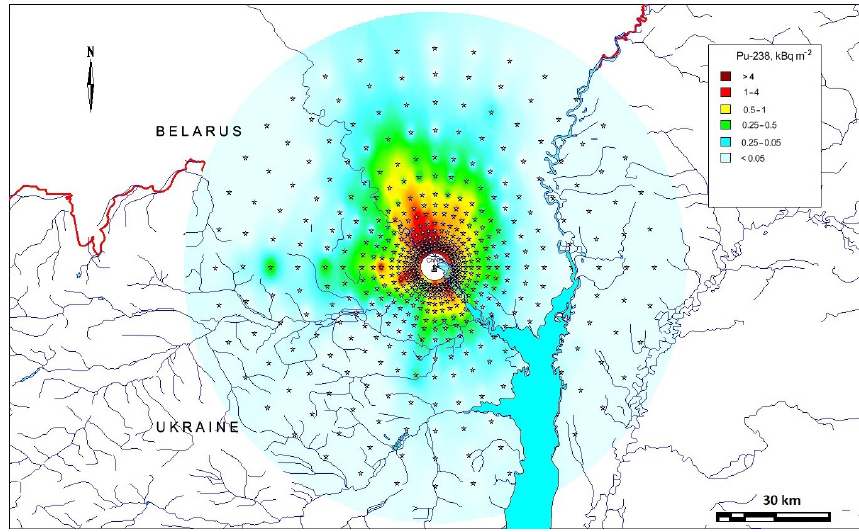
Figure 8. The fallout density of 238 Pu (kBqm 2 ) corrected to 6 May 1986; estimated from measurements of 144 Ce in the soil and estimated activity concentrations in the fuel of the ChNNP reactor number four (note that no data were available for less than 5km from ChNPP and no interpolation for this area has been